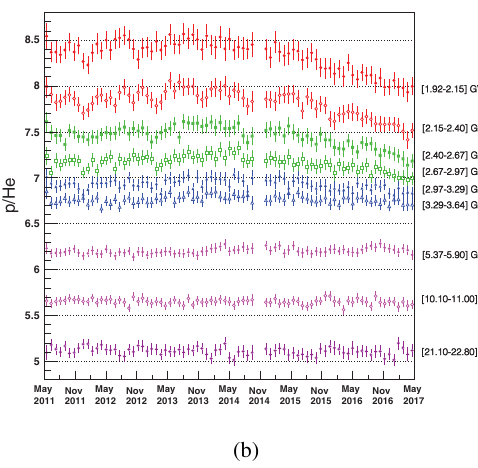
FIG. 3. Comparison of the fine structure time dependence of (a) the AMS proton flux for [1.19 – 1.40] GeV together with the measurement by EPHIN aboard SOHO for [1.12 – 1.29] GeV [36], (b) the AMS helium flux for 1 . 11 – 1 . 28 GeV =n , (c) the ½ & relative variation of the AMS proton flux integrated over R ≥ 6 . 47 GVasafunctionoftimetogether withtherelativevariation of the rate reported by the Oulu, Finland neutron monitor [37], and (d) the monthly averaged sunspot number [38] with the period of solar magnetic field polarity ( A ) reversal (vertical dashed lines) from A < 0 to A > 0 , November 2012 to March 2014, of solar cycle 24 [39]. One year after solar maximum, both the p and He fluxes start to rise and, as seen, there is a negative correlation with the sunspot number. AMS data are converted from rigidity R to kinetic energy per nucleon =A , where M is the proton or the Z 2 R 2 M 2 p − M E K FIG. 4. The AMS p= He flux ratio as function of time for 9 Þ ¼ ð þ 4 He mass. The AMS error bars are the quadratic sum of the characteristic rigidity bins. The errors are the quadratic sum of ffiffiffiffiffiffiffiffiffiffiffiffiffiffiffiffiffiffiffiffiffiffiffi statistical and total systematic errors. the statistical and time dependent systematic errors. The solid lines are the best fit of Eq. (2) for the first 5 rigidity bins from [1.92 – 2.15] GV to [2.97 – 3.29] GV. The vertical band (February 28, 2015 42 days) is the average of the best fit values of t i for ! these rigidity bins.